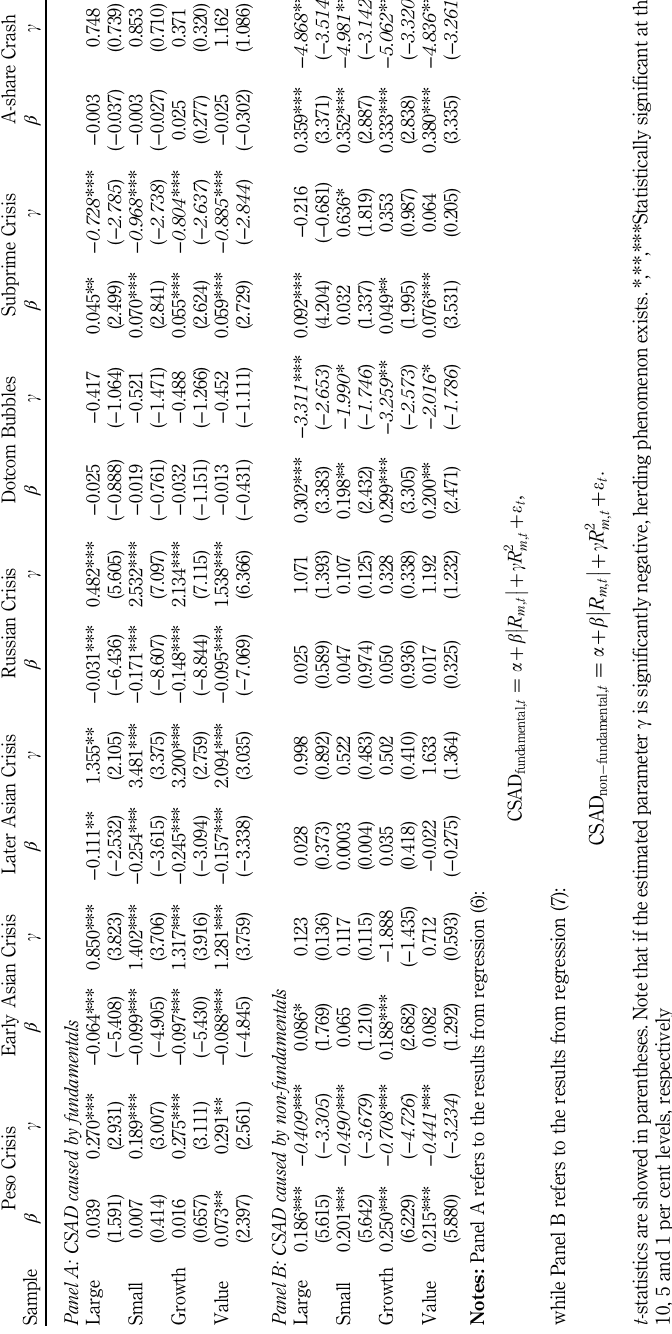
Table V. A-share market: herding and fundamentals by sub- sample